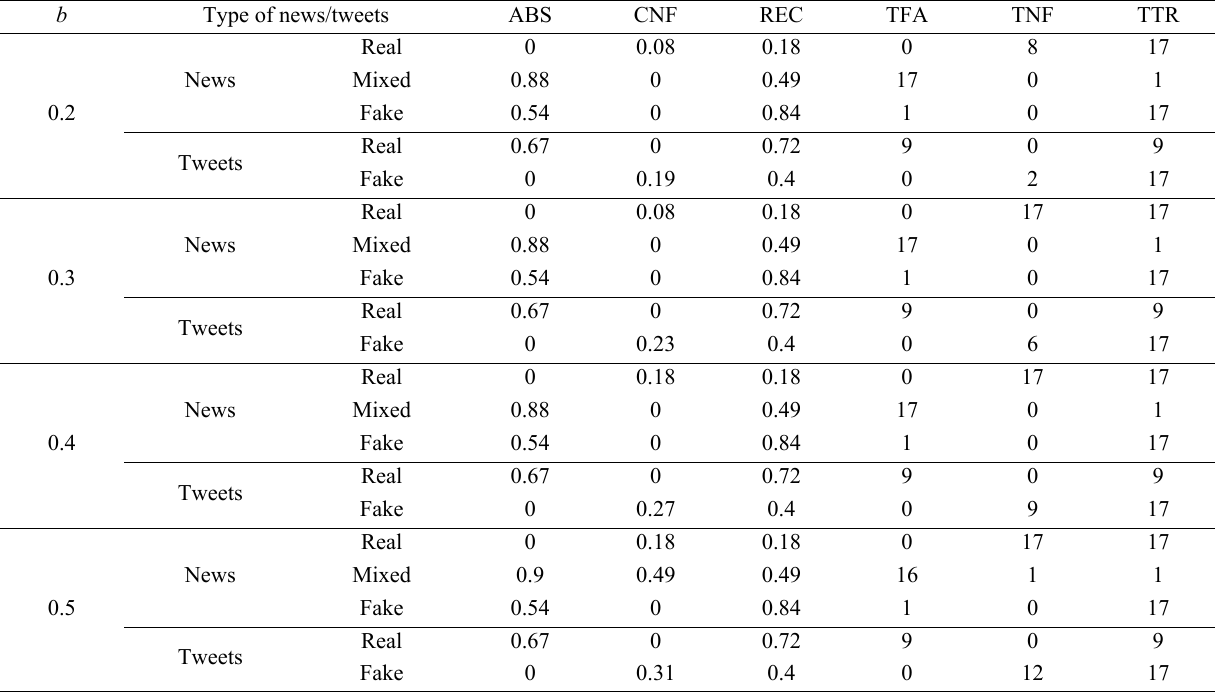
Table 10 Absorption (ABS), community non-functioning (CNF), recovery (REC), time for absorption (TFA), time under community non-functioning (TNF), and time to recovery (TTR) for news and tweets with the critical community capital functionality threshold b varying over the range of 0.2–0.5.